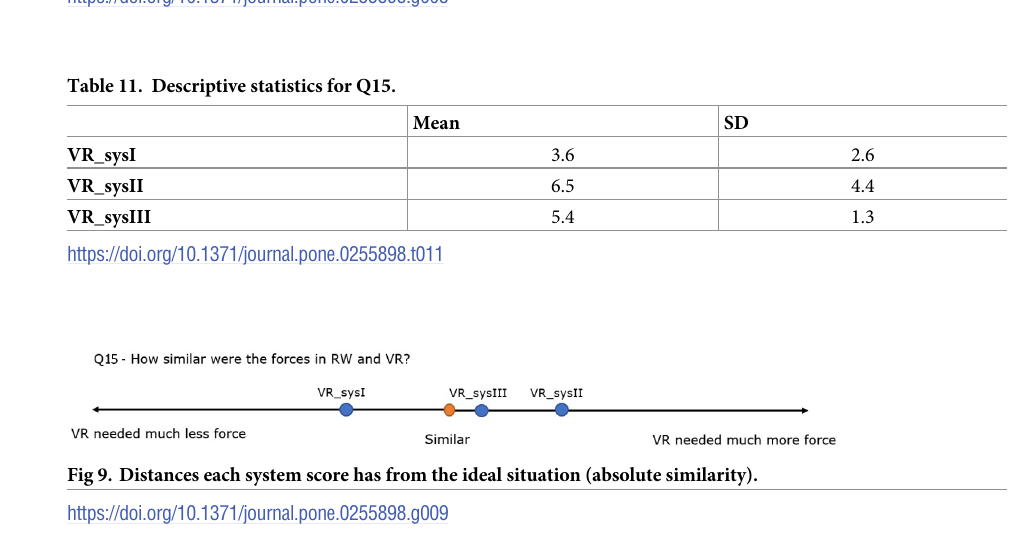
Fig 8. The linear trend for INV and ER among the three systems. The system with the lowest scores (VR_sysII) was placed far left and the system with the highest scores (VR_sysIII) was placed far right on the horizontal axis.